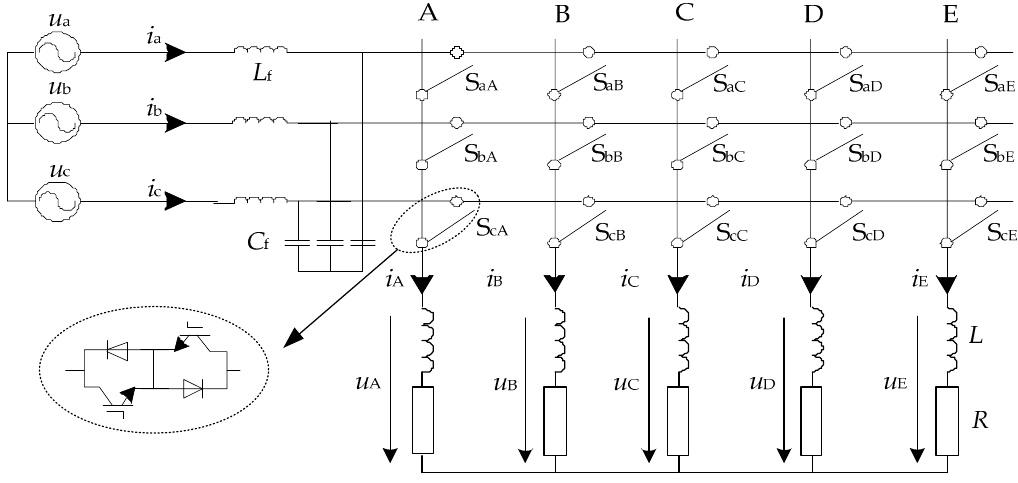
Figure 1. Topology of a three ‐ to ‐ five phase MC.